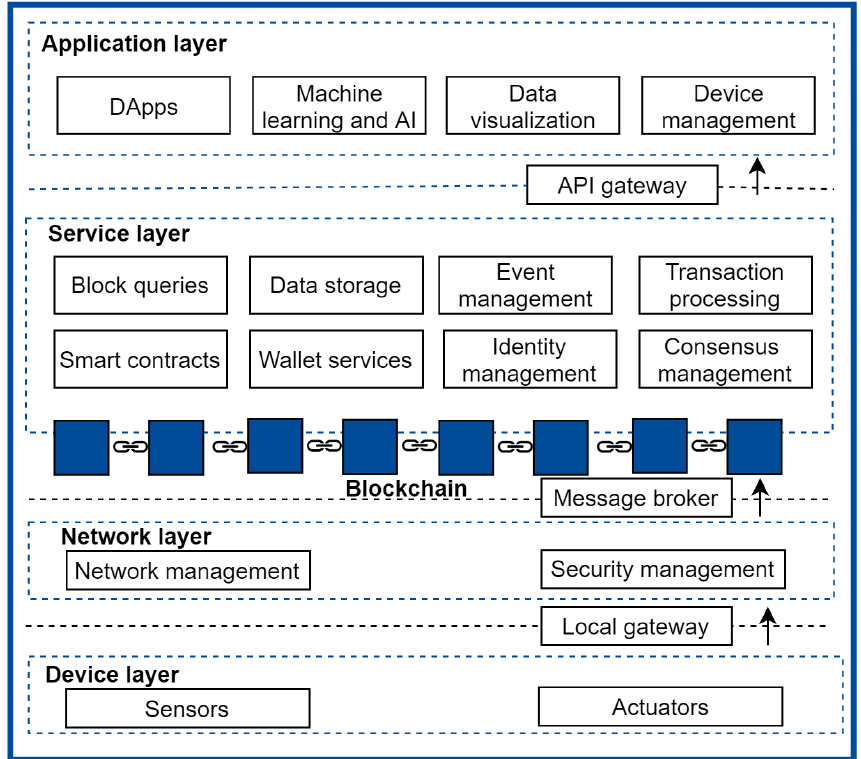
Figure 2. The architecture overview of the proposed blockchain based Internet of Things